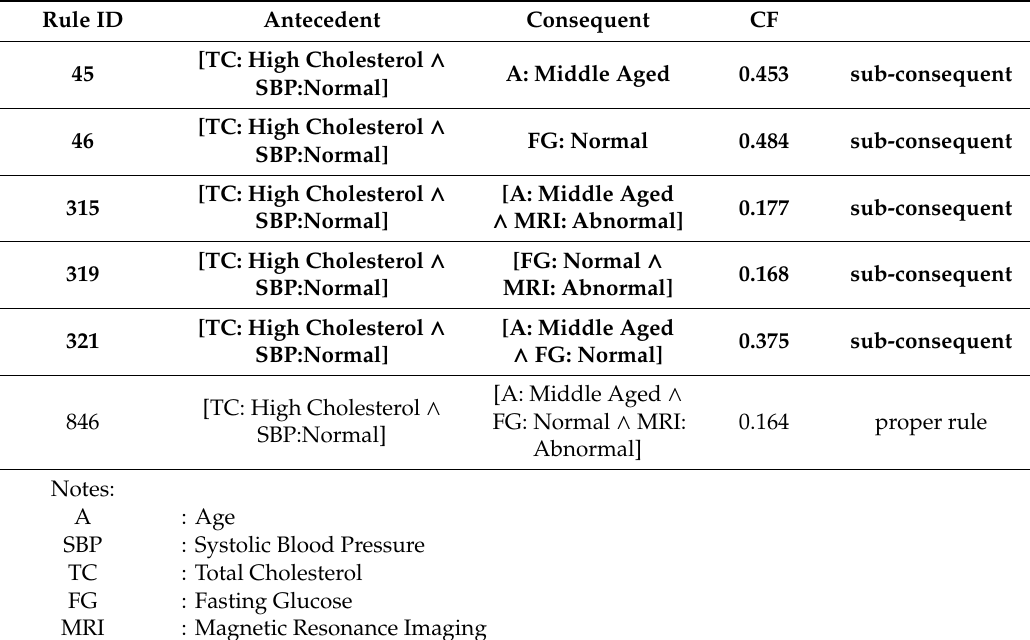
Table 5. Example of subsumption rules (proper rule and its